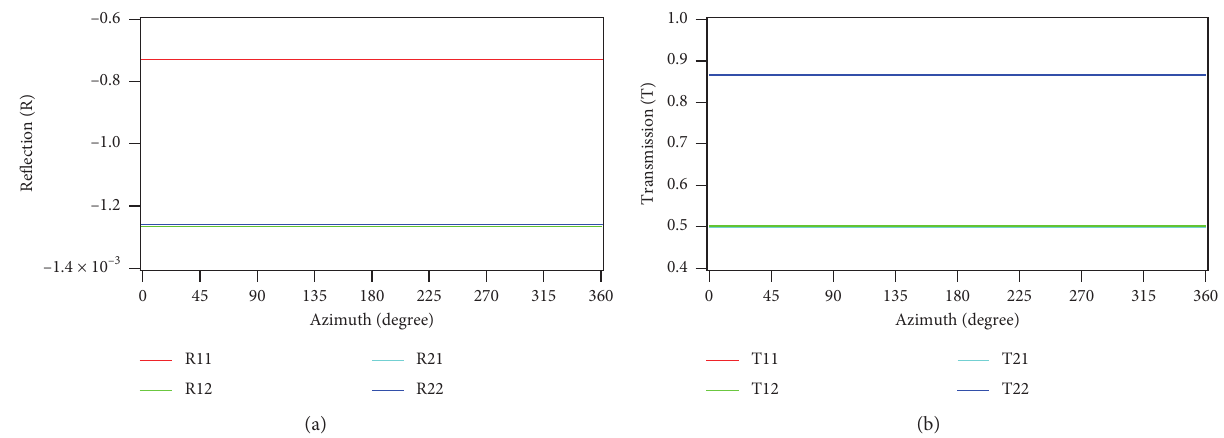
Figure 3: The reflection and transmission coefficients from an interface between two homogeneous anisotropic ice layers. The measurement coordinate rotates from 0 to 2 π in the horizontal plane.